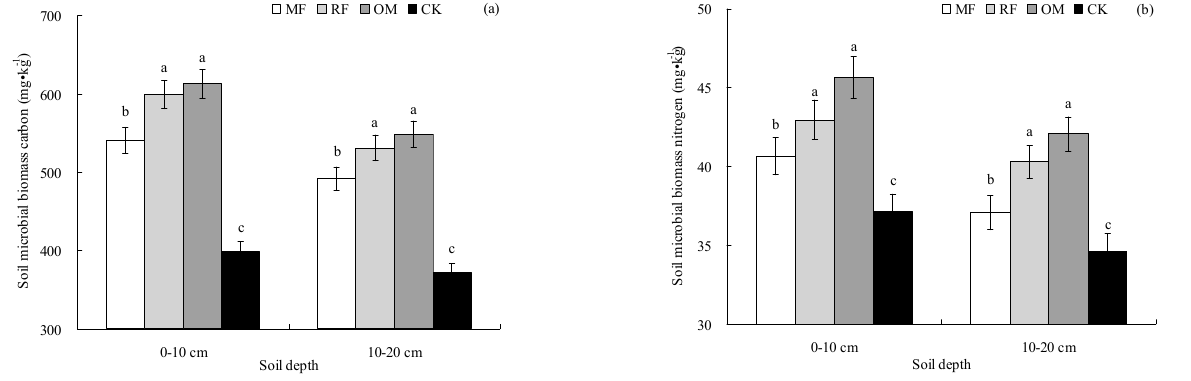
Figure 1. Effects of different long-term fertilizer treatments on soil microbial biomass carbon ( a ) and nitrogen ( b ) contents in the double-cropping rice field. MF: chemical fertilizer alone; RF: rice straw residue and chemical fertilizer; OM: 30% organic manure and 70% chemical fertilizer; CK: without fertilizer input as a control. Different lowercase letters indicate significant differences ( p < 0.05) among different fertilizer treatments.